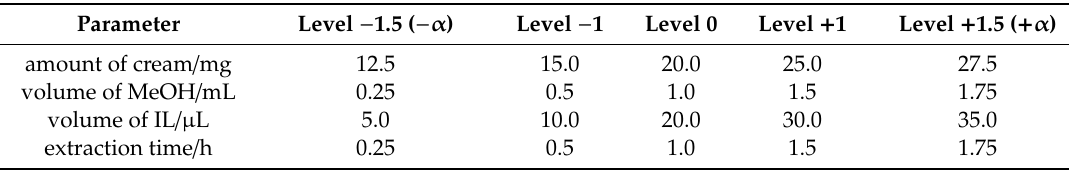
Table 1. Parameter levels for the full central composite